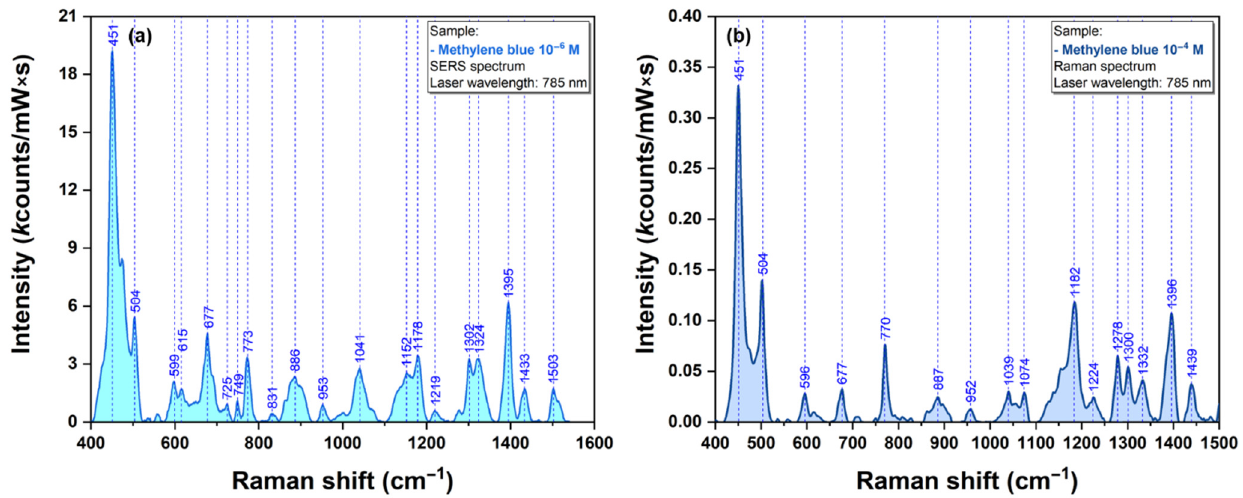
Figure 7. SERS spectrum of dried MB solution (1 µM) using a 785 nm excitation laser ( a ). Raman spectrum of dried MB solution (1 µM) using a 785 nm excitation laser ( b ).